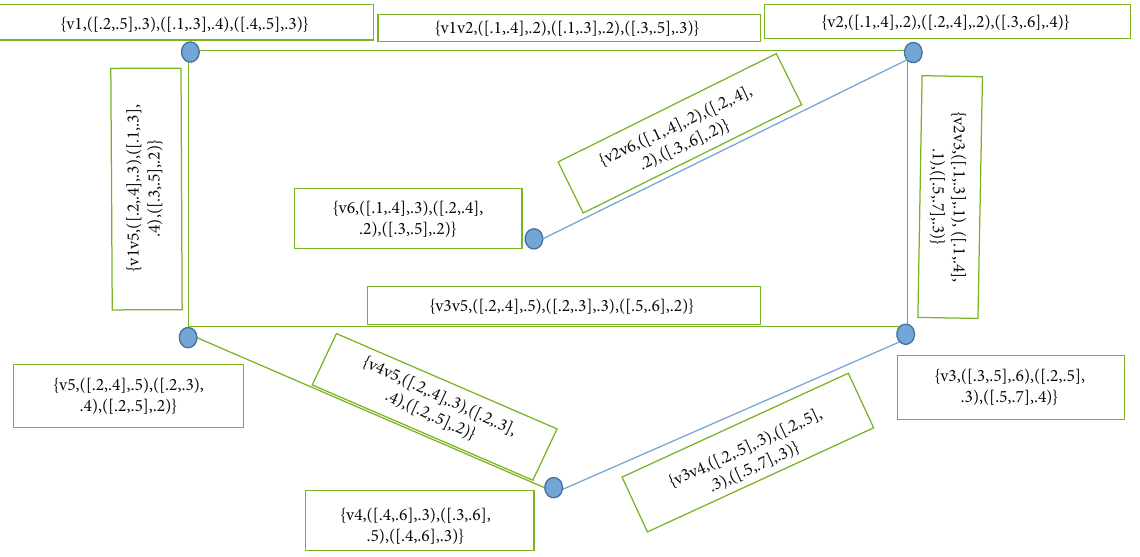
Figure 9: Represents highly irregular neutrosophic cubic